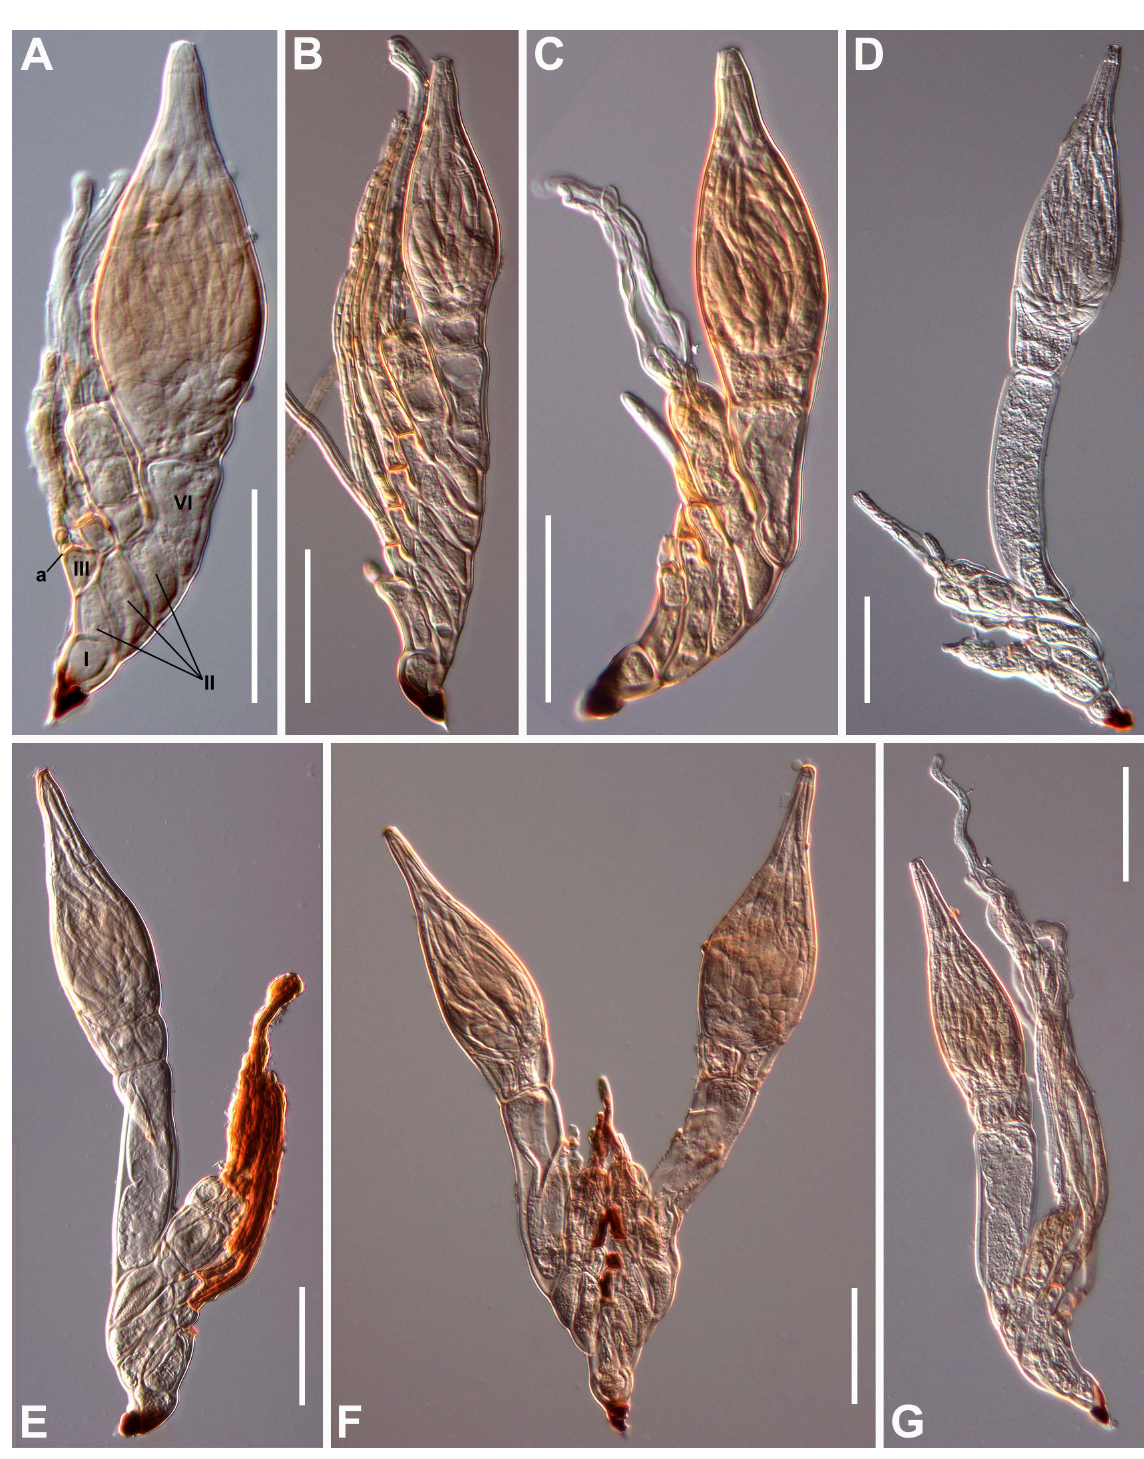
Fig. 87. Monoicomyces invisibilis Thaxt. A . Mature thallus from Platystethus arenarius showing cells I, II (subdivided into three cells), III, VI, and primary septum (a). B – C . Mature thalli from Oxytelus fulvipes . D , F . Mature thalli from Anotylus sculpturatus . E , G . Mature thalli from Anotylus inustus . Scale bars: 50 µm. Photographs from slides ZMUC C-F-123613 (A), ZMUC C-F-122951 (B), ZMUC C-F-123161 (C), ZMUC C-F-123406 (D), ZMUC C-F-122676 (E), ZMUC C-F-123003 (F), ZMUC C-F-123177